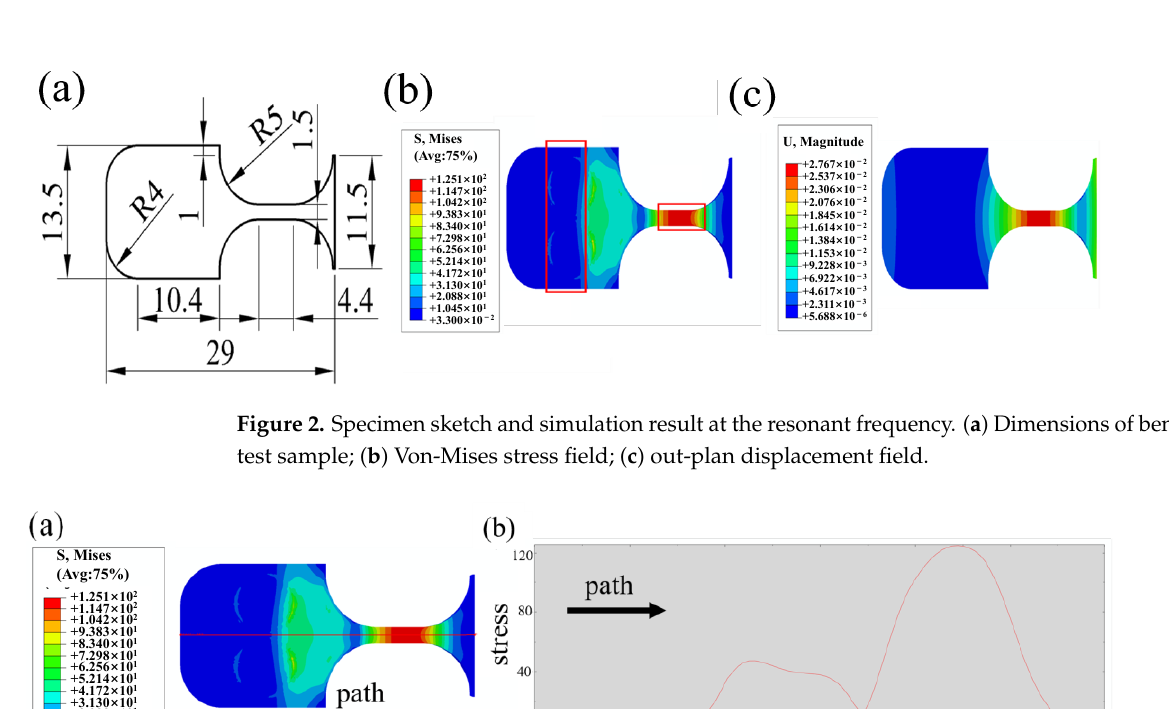
Figure 2. Specimen sketch and simulation result at the resonant frequency. ( a ) Dimensions of bend- ing test sample; ( b ) Von-Mises stress field; ( c ) out-plan displacement field.